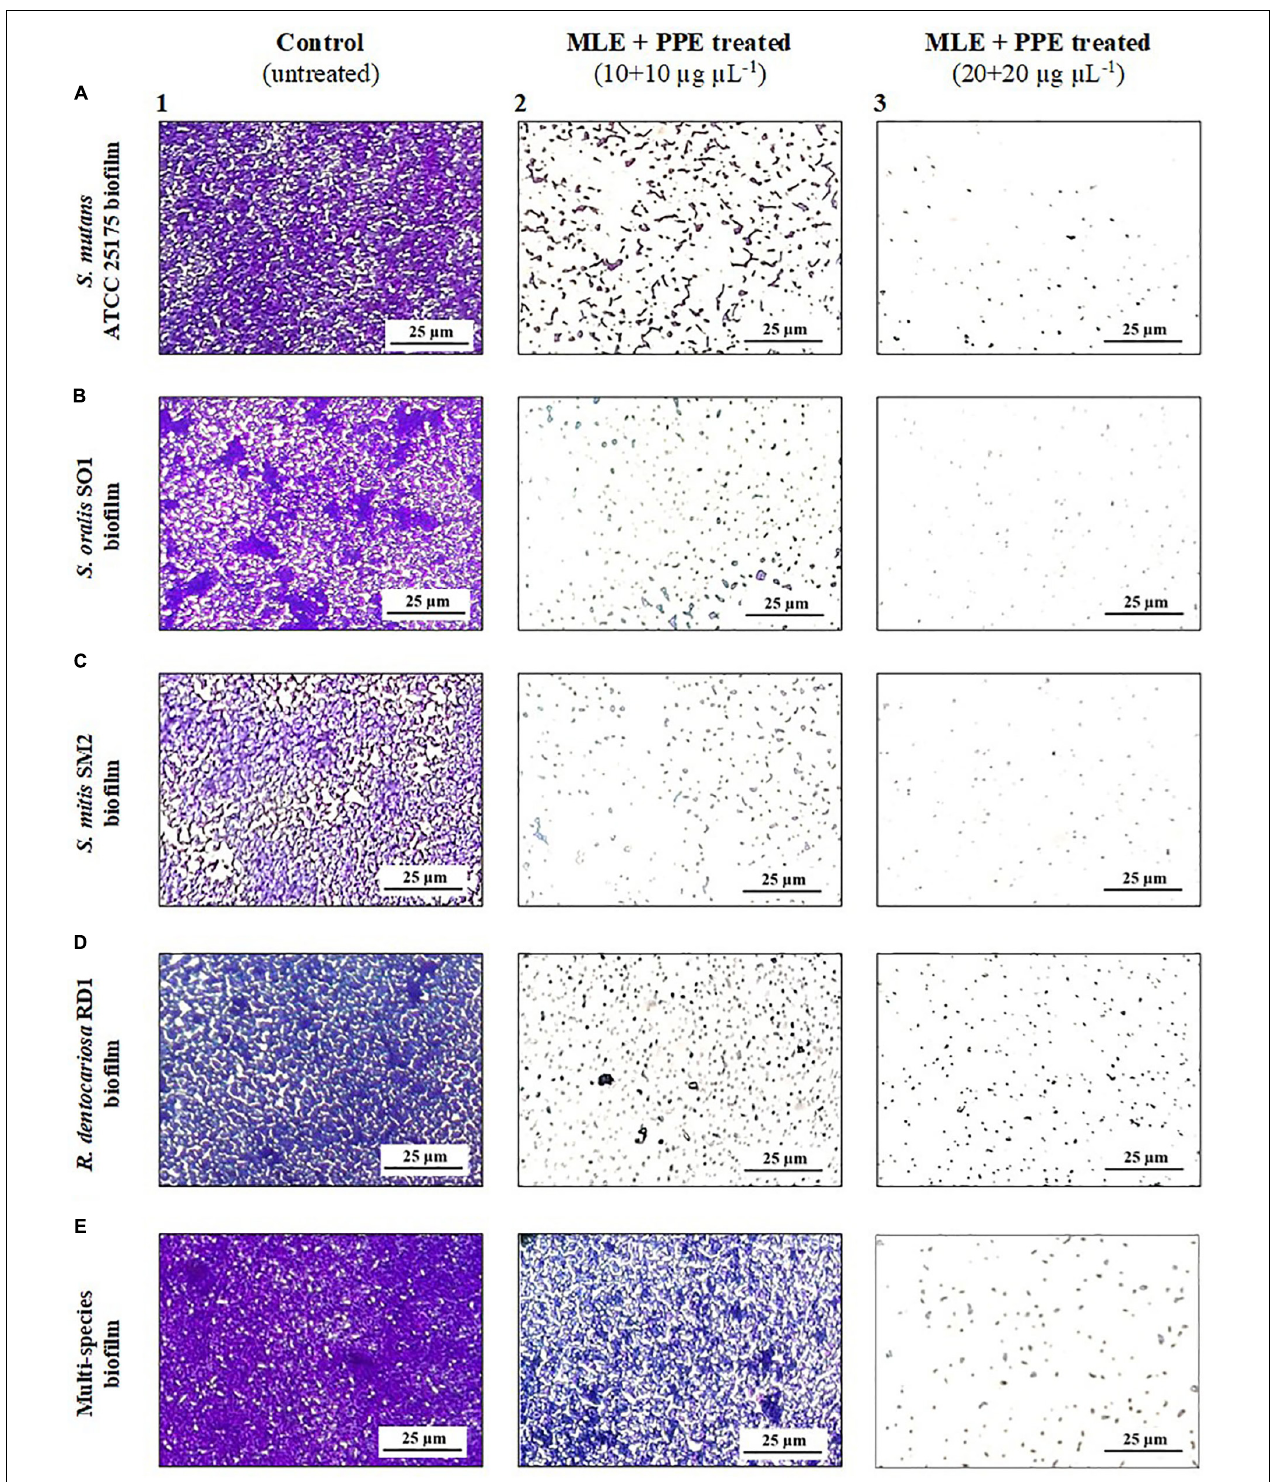
FIGURE 4 | Light microscopy images of mature S. mutans ATCC 25175 (A) , S. oralis SO1 (B) , S. mitis SM2 (C) , R. dentocariosa RD1 (D) , and multispecies (E) biofilms (1:1:1:1 ratio for each isolate) grown with and without treatment with myrtle extract in binary combination with pomegranate extract. Crystal violet staining; MLE + PPE, myrtle leaf 50% ethanolic extracts in binary combination with pomegranate peel 50% ethanolic extracts (1:1 ratio).